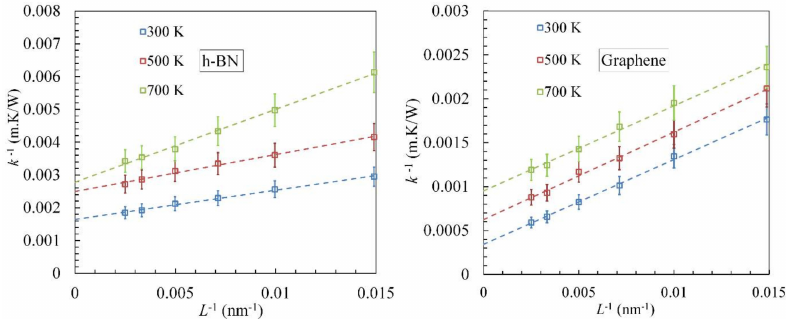
Figure 6. The calculated inverse of thermal conductivity vs. inverse of length of h-BN and Graphene sheets based on the variation of sheet length and temperature. To extrapolate the thermal conductivity for infinite sheets, the inverse of the thermal conductivity is plotted versus the inverse of the length. The dashed-line is employed to demonstrate the length dependence of the thermal